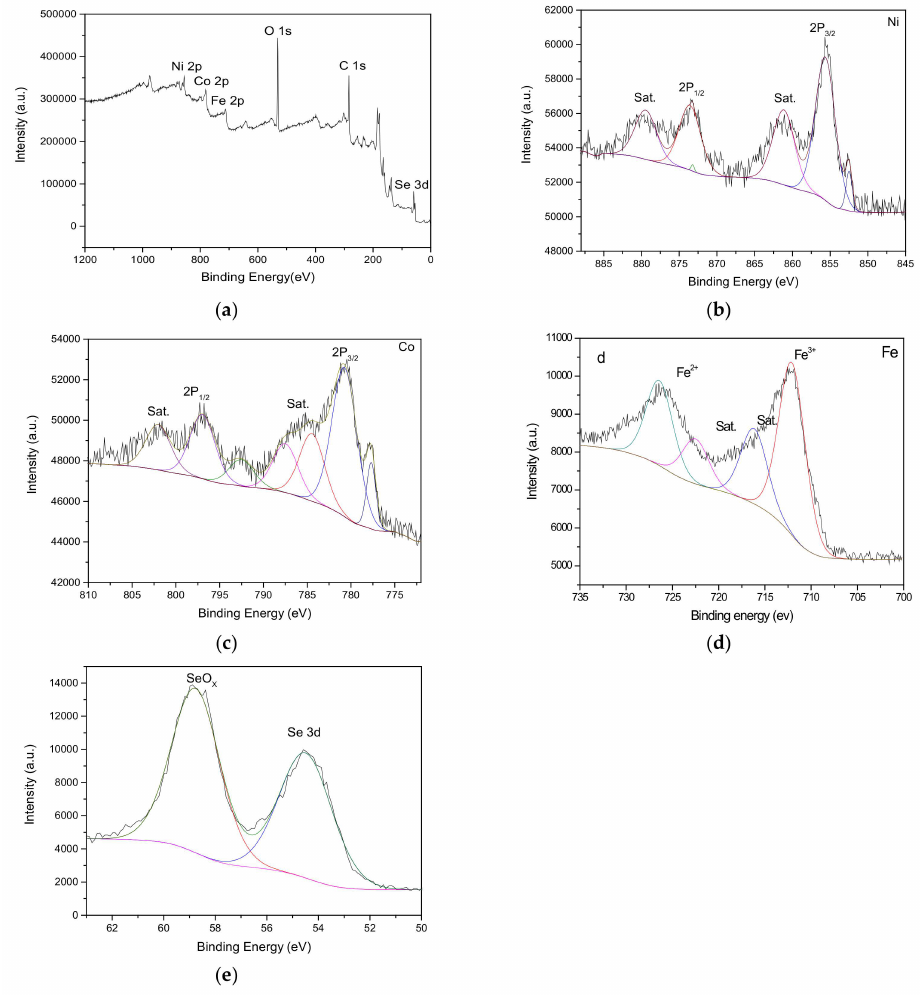
Figure 4. ( a ) XPS survey of (Ni 0.62 Co 0.35 Fe 0.03 ) 3 Se 4 /CC; ( b ) Ni 2p; ( c ) Co 2p; ( d ) Fe 2p; and ( e ) Se 3d XPS spectra of (Ni 0.62 Co 0.35 Fe 0.03 ) 3 Se 4